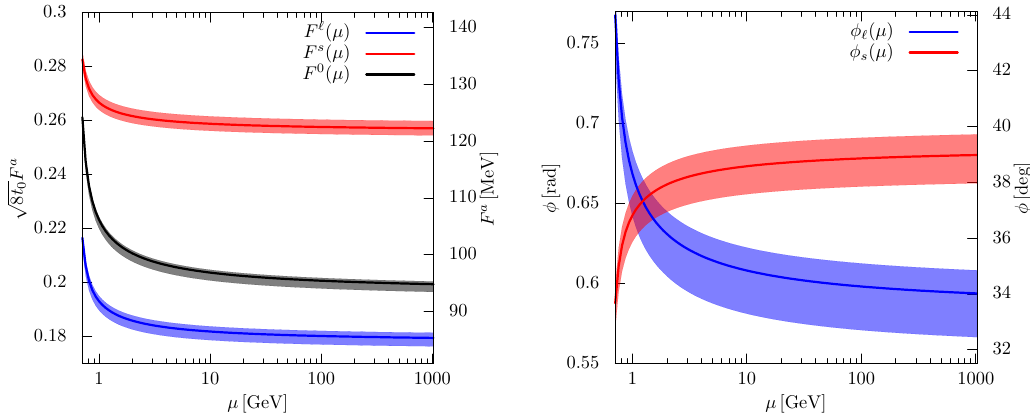
Figure 13. Scale dependence of the decay constants and their mixing angles in the flavour basis. The approximation φ ‘ ≈ φ s ≈ φ is only valid for µ inbetween about 1 GeV and 2 GeV . In the same region the decay constants vary considerably with the scale. The (asymmetric) errors indicated by the coloured bands are statistical